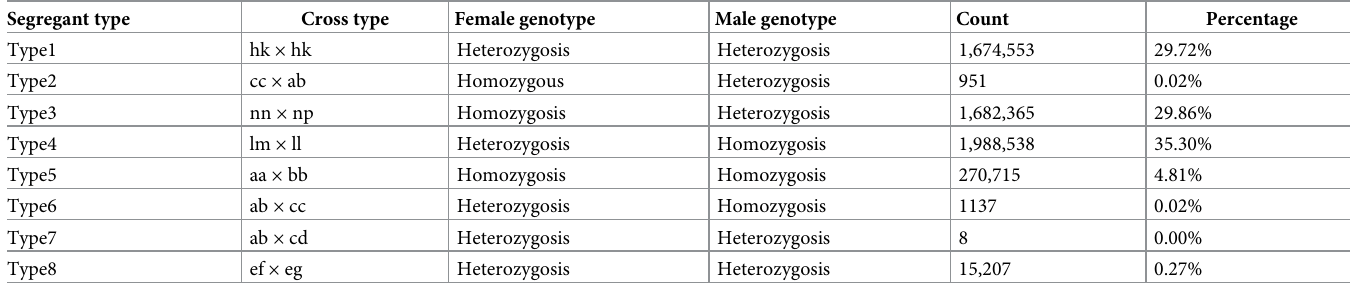
Table 3. Segregation distortion for SNP